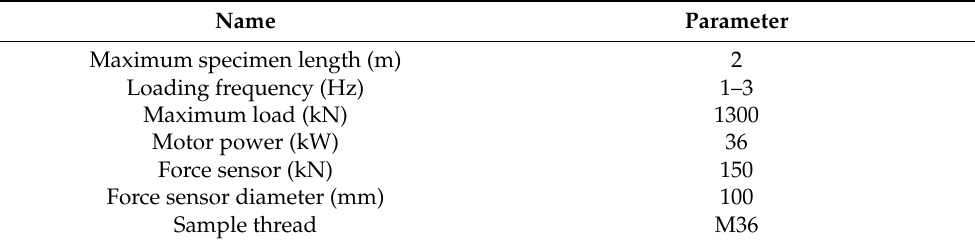
Table 1. Design parameters.